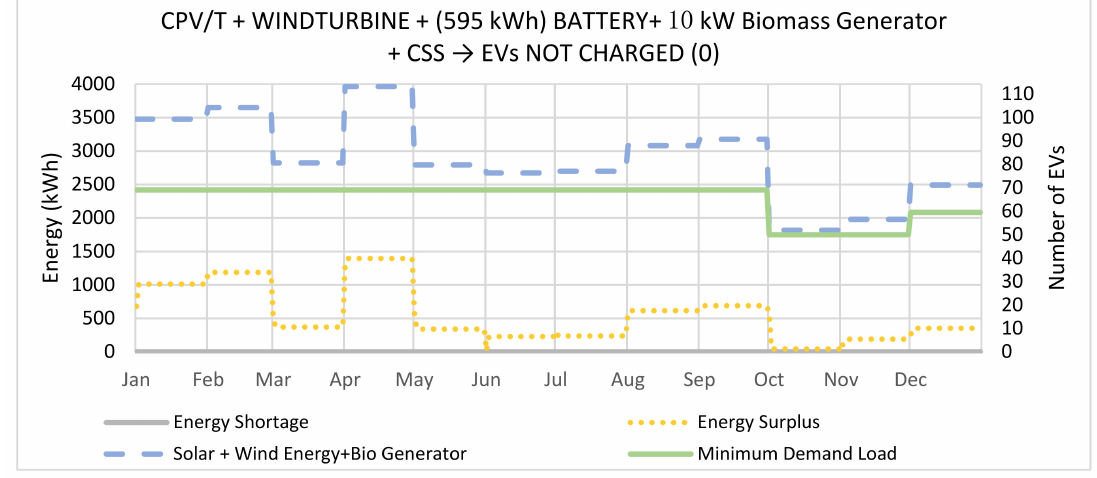
Figure 20. Overall system’s annual simulation results with the optimized operation of the CSS.